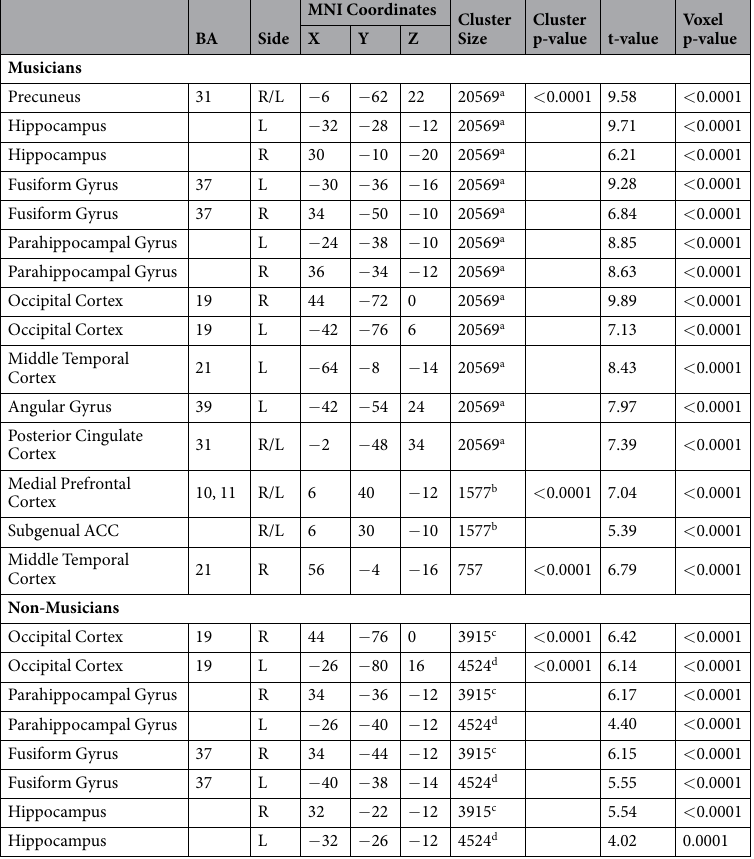
Table 5. Brain regions showing significant between-group differences in the “Improvise > Reproduce” contrast. ACC, Anterior Cingulate Cortex; BA, Brodmann Area; R, Right; L, Left; a,b indicates part of the same cluster. All results survived the Alphasim correction for multiple